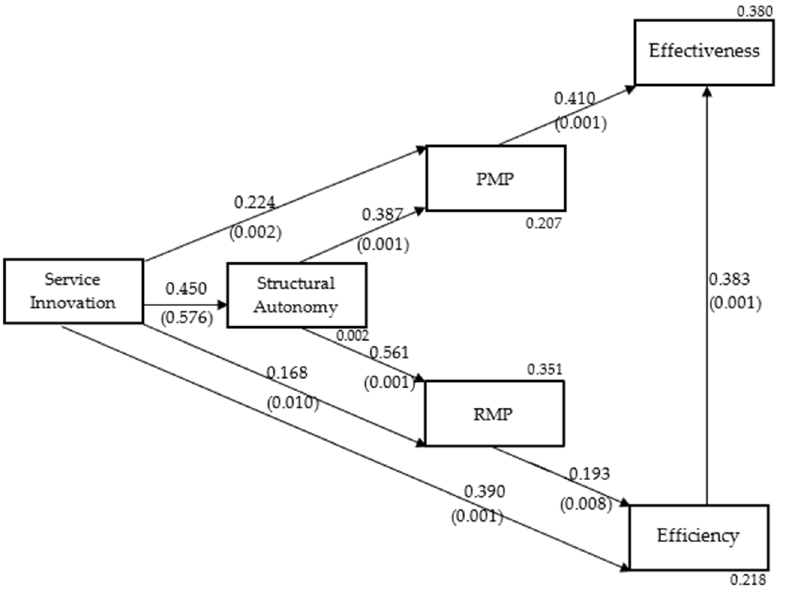
Figure 2. The final model of structural equations.